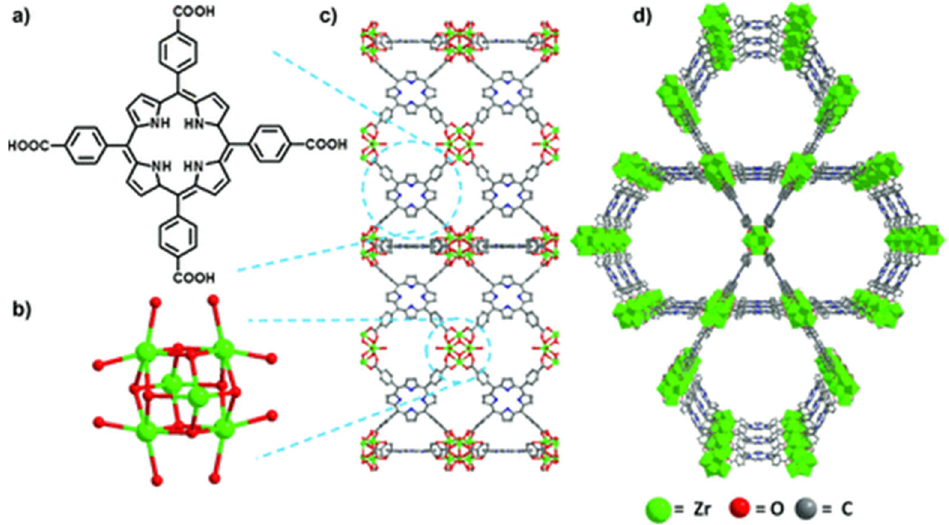
Figure 6. Comparison of free-base PCN-222/MOF-545 (fb-1). ( a ) Tetrakis(4-carboxyphenyl)porphyrin linker, H 4 TCPP. ( b ) [Zr6(m3-O)8(O)8]8¢ node. ( c ) MOF fb-1, shown across the axis a ( d ) 3D structure of fb-1, depicted along the c axis. For more clarity hydrogen atoms has been omitted. Reprinted with permission from [54].